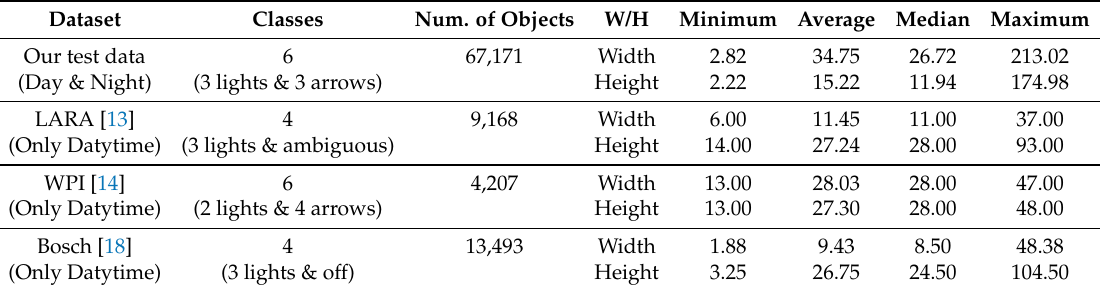
Table 3. Bounding box pixel size in test dataset and other open